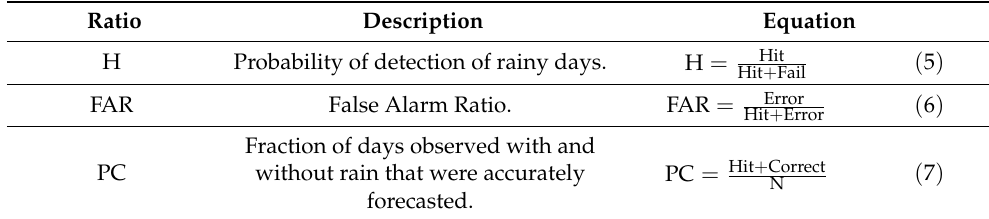
Fraction of days observed with and without rain that were accurately